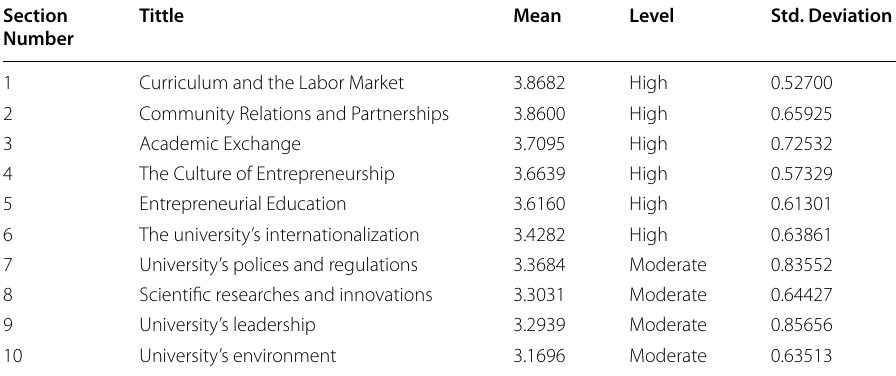
Table 3 Means and Std. deviations of the reality of entrepreneurship at PPU Section